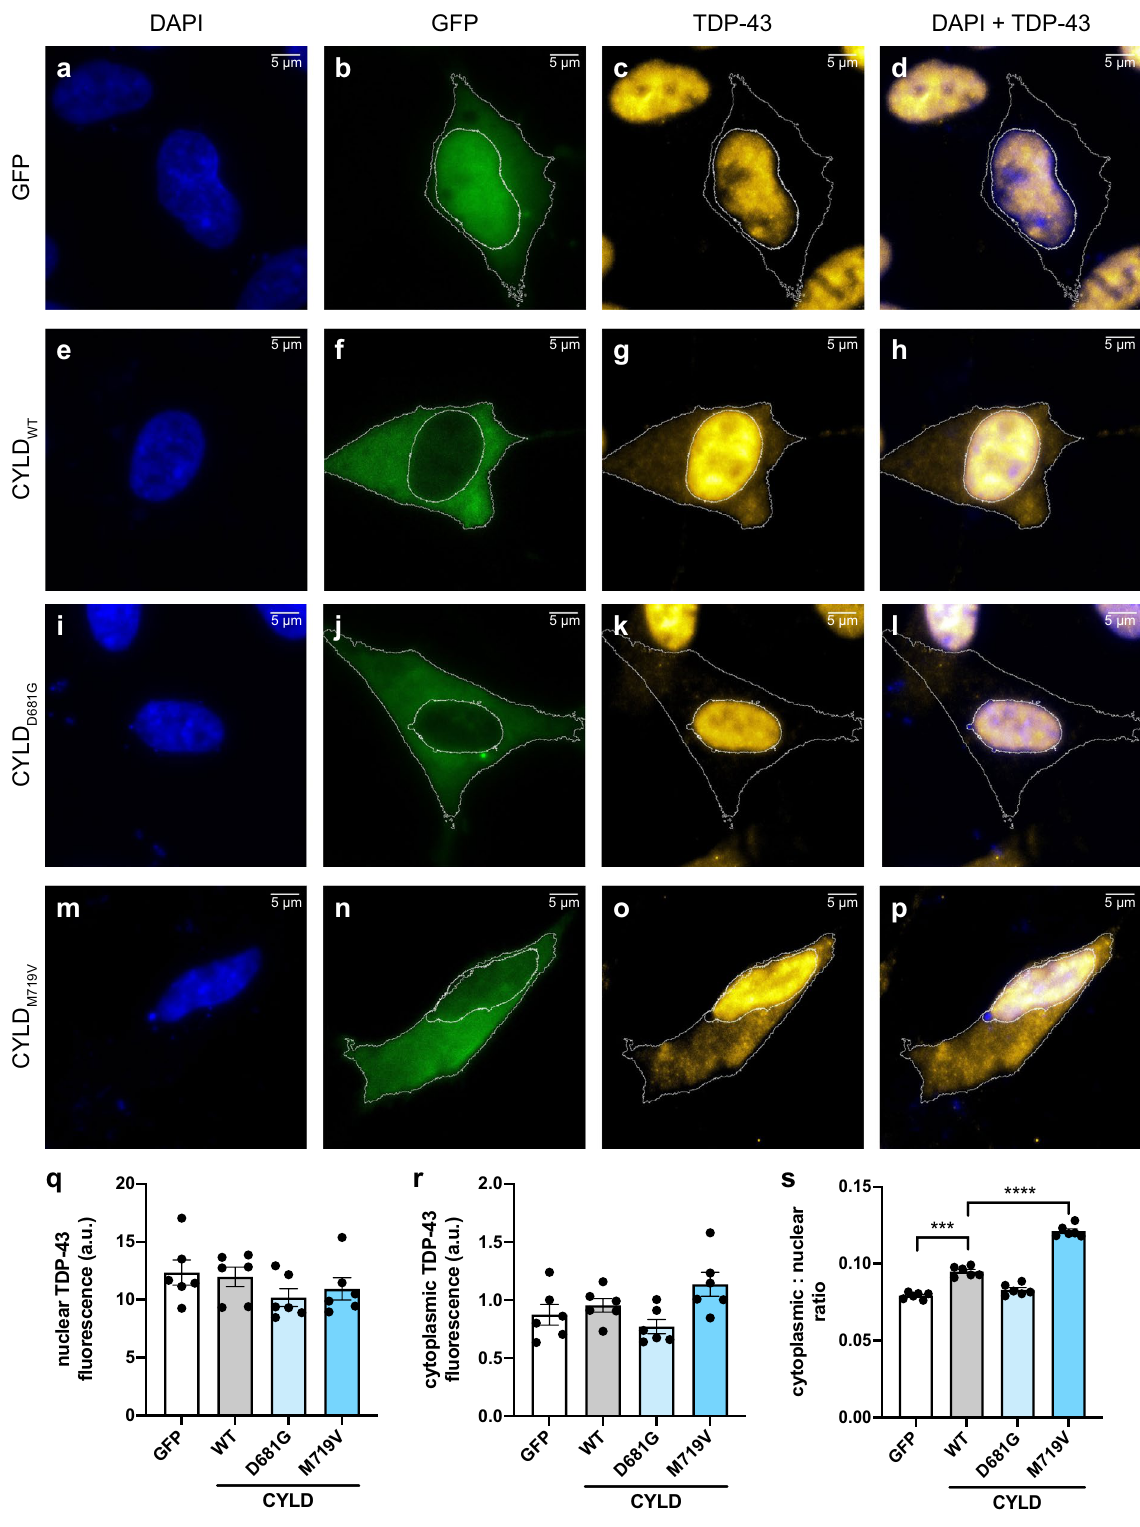
Figure 4. Detection of endogenous TDP-43 cytoplasmic mislocalisation in cells expressing CYLD mutations. Representative images of SH-SY5Y cells overexpressing ( a – d ) GFP or GFP-tagged ( e – h ) CYLD WT , ( i – l ) CYLD D681G or ( m – p ) CYLD M719V . TDP-43 was detected by immunofluorescent staining (yellow) and nuclei were visualised with DAPI (blue). ( q ) Quantification of the fluorescence intensity of the nucleus and ( r ) cytoplasm shows no difference in TDP-43 expression. ( s ) Quantification of the cytoplasmic/nuclear ratio of exogenous TDP-43 shows a marked increase in CYLD WT , when compared to cells expressing GFP. The cytoplasmic/nuclear ratio of TDP-43 in CYLD M719V -expressing cells was significantly higher than CYLD WT . Scale bars = 5 μm. Data is represented as mean ± SEM. a.u. arbitrary units. ***p < 0.001; ****p <